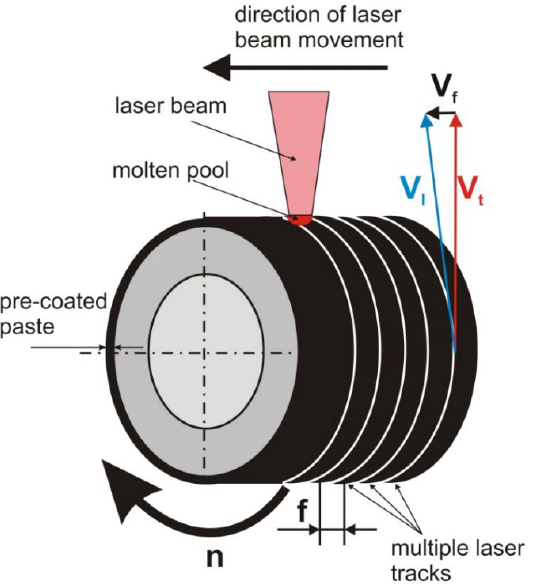
Figure 1. The scheme of laser boriding with pre-coated paste—the method of multiple laser tracks producing v f —feed rate; v l —scanning rate; v t —tangential speed; n—rotational speed; f—distance between the axes of adjacent tracks.